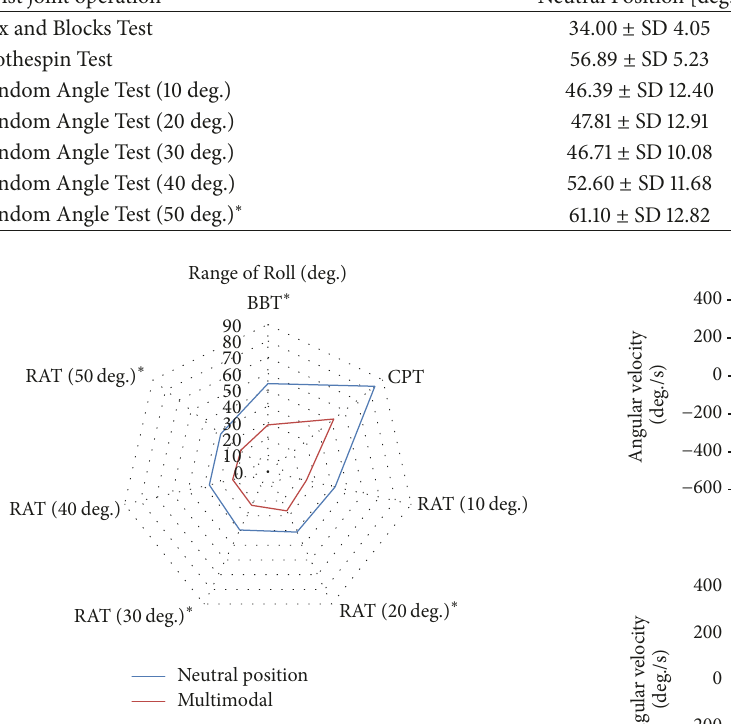
Figure 14: Radar chart of the means and significant difference ( ∗ 𝑝 < 0.05 , 𝑁 = 4 ).